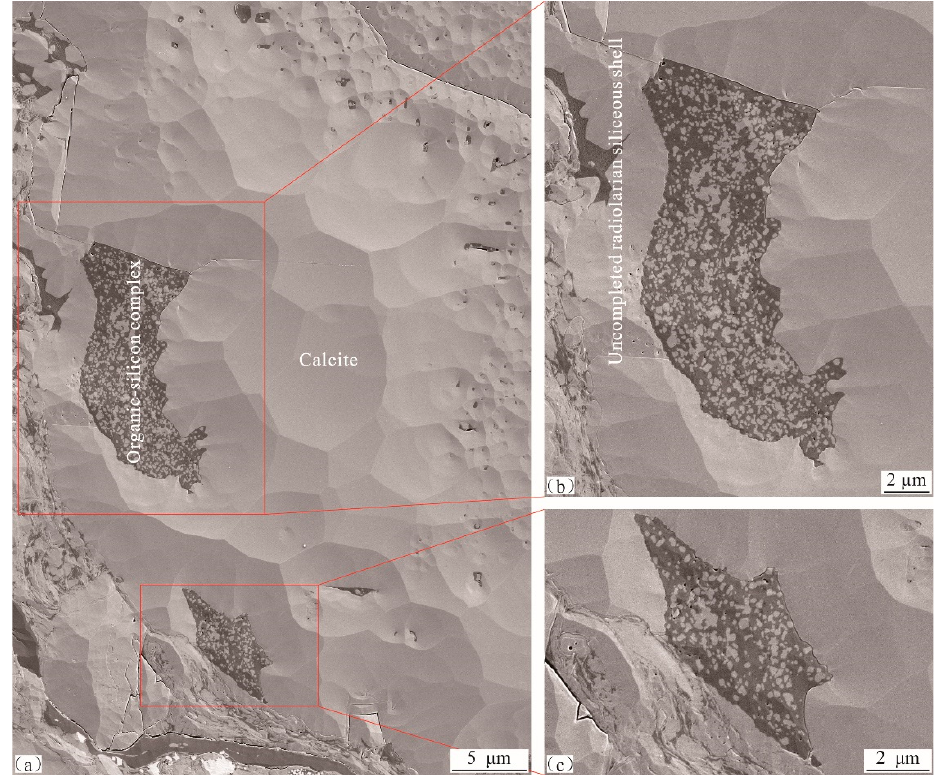
Figure 6. Typical images of calcite dissolution and organic–silicon complex in uncompleted radiolarian siliceous shell cavities. ( a ) Calcite and organic–silicon complex in the uncompleted radiolarian siliceous shell cavity. ( b ) Enlarged image ( a ), dissolved pores of calcite, filled by organic–silicon complex with no pores. ( c ) Enlarged image ( a ), no pores in organic–silicon complex contacting with clay minerals.